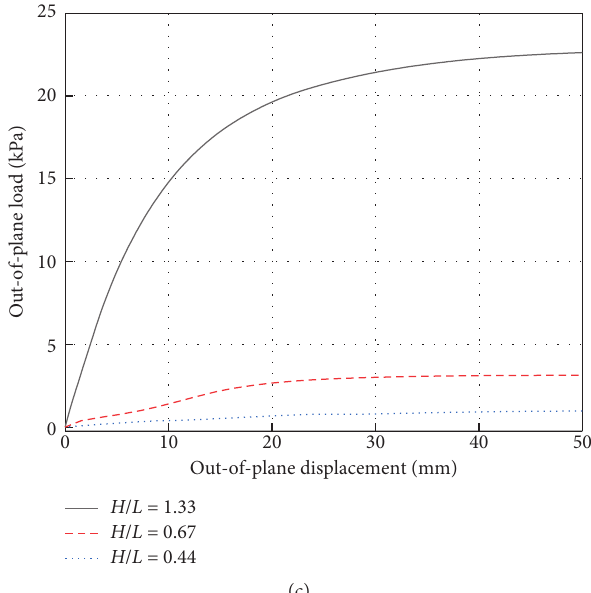
Figure 7: OOP load-displacement curves of infill walls with different aspect ratios. (a) Without IP damage. (b) With IP damage (IDR � 0.3%). (c) With IP damage (IDR �